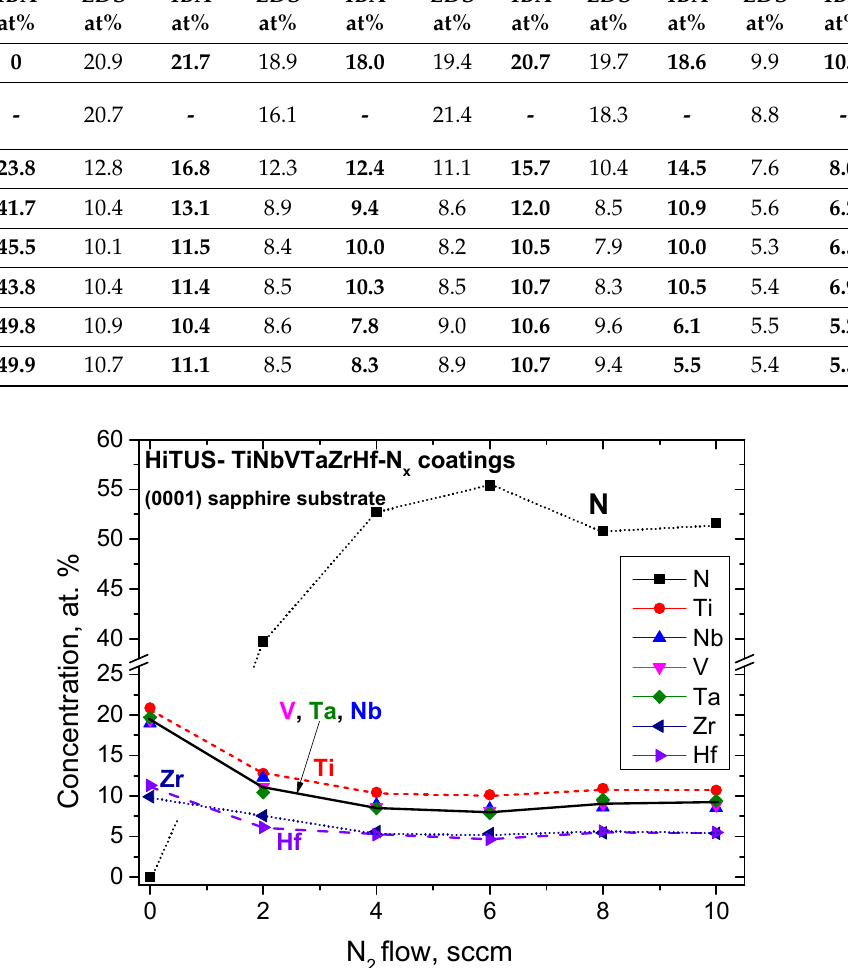
Figure 9. Average semi-quantitative EDS compositions of the studied reactive HiTUS TiNbVTaZrHf-xN coatings (x–flow of nitrogen in sccm) as a function of nitrogen additions in the Ar sputtering atmosphere. The averaging was based on top-view measurements in SEM from four large (900 × 680 µm 2 ) areas.